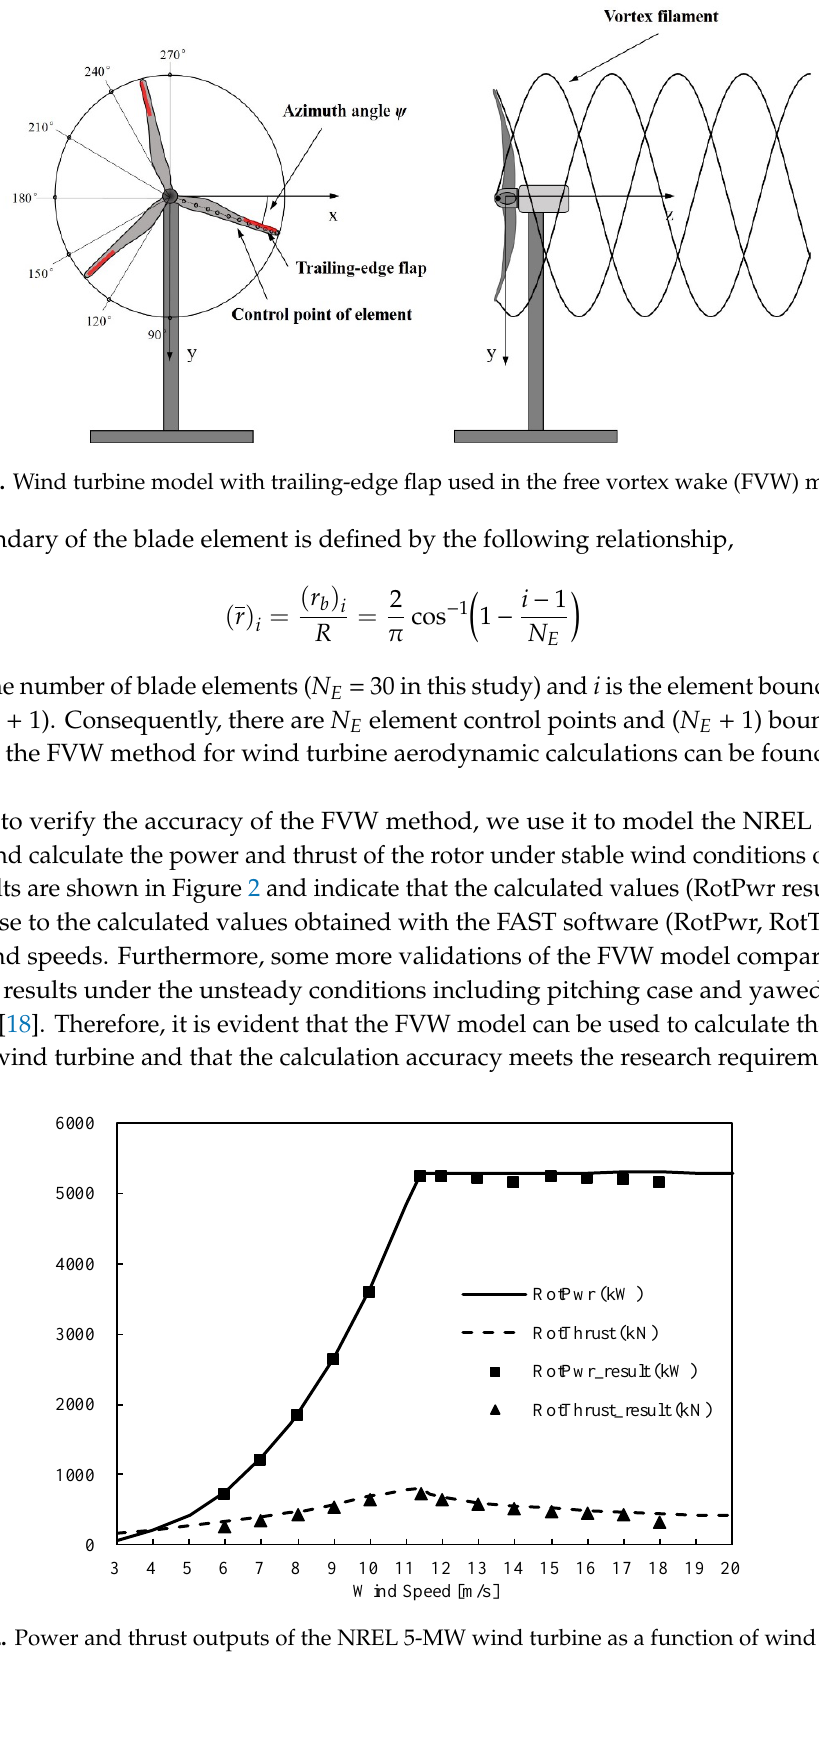
Figure 2. Power and thrust outputs of the NREL 5-MW wind turbine as a function of wind speed.